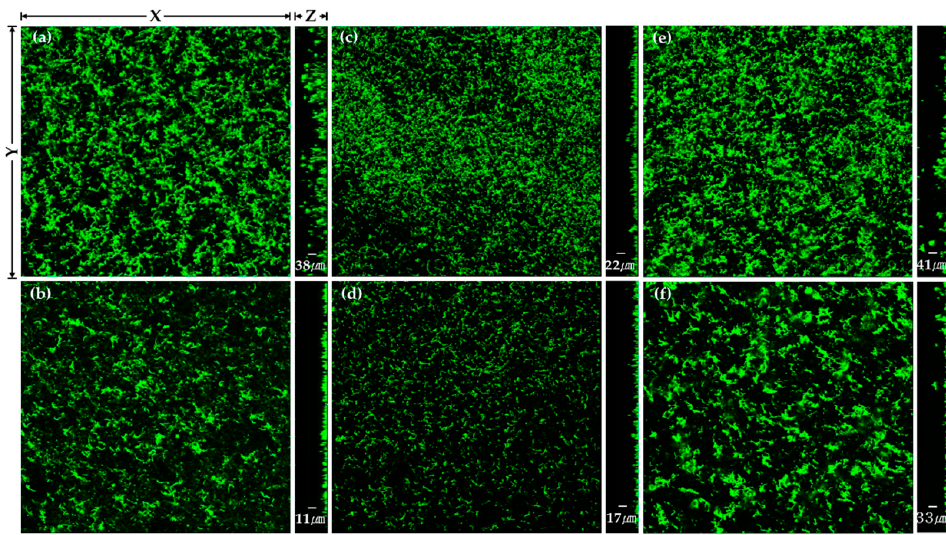
Figure 5. CLSM image of Streptococcus mutans biofilm on ( a ) H0, ( b ) H0P, ( c ) H400, ( d ) H400P, ( e ) H600, and ( f ) H600P samples. Green fluorescence indicates viable cells.